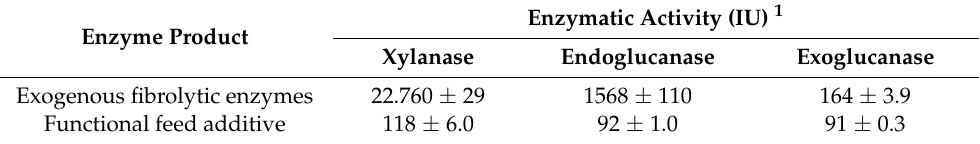
Table 1. Xylanase, endoglucanase, and exoglucanase activities of the experimental feed additives. Enzyme